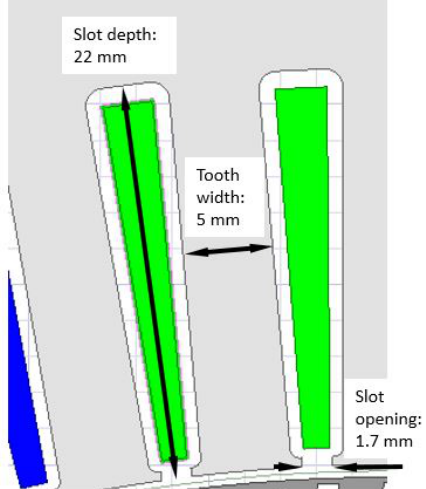
Figure 2. The main dimensions of a slot.